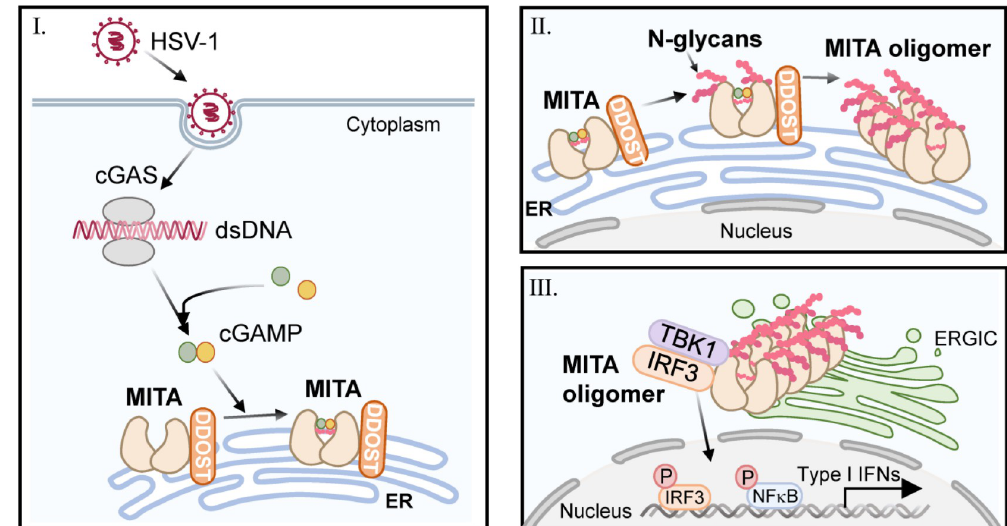
Fig 7. The graphical abstract of DDOST-regulated MITA-mediated signaling